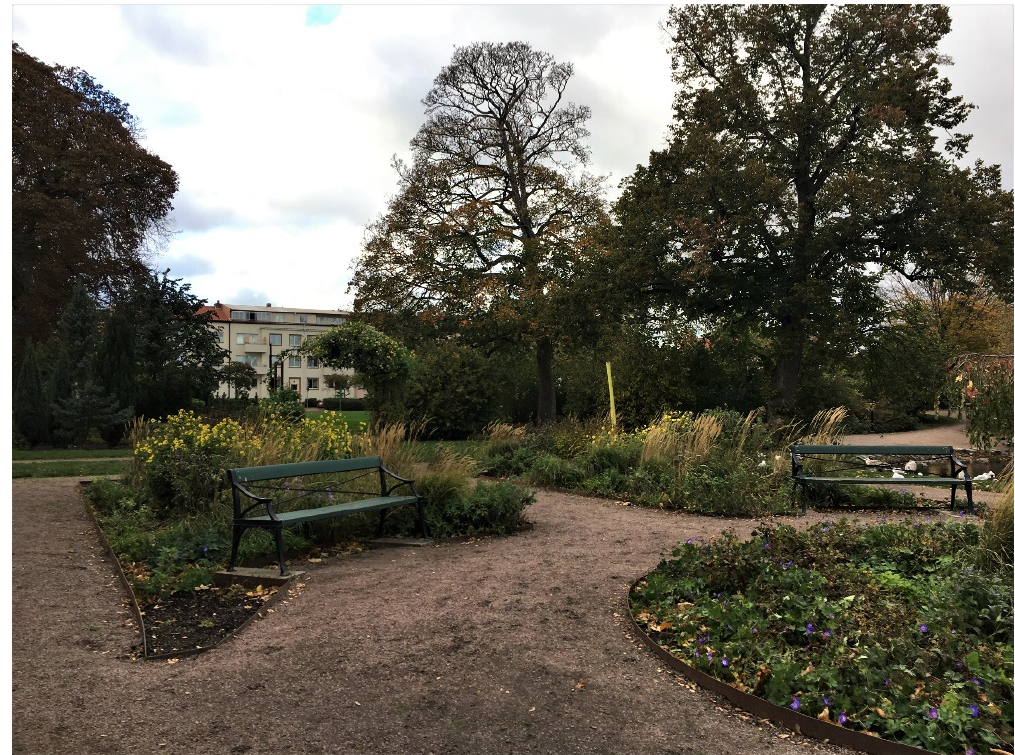
Figure 7. Seating by the perennial beds used for spontaneous meetings among the elderly.